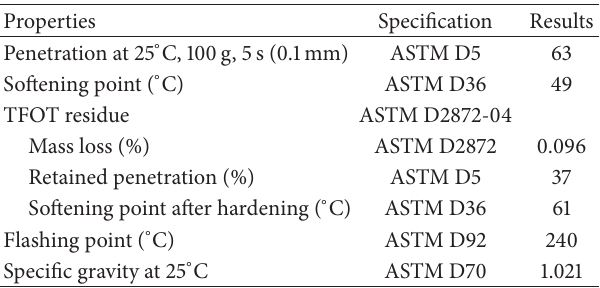
Figure 1: Aggregate gradation of porous asphalt mixture with specification limits of PEM. Table 3: Physical properties of conventional bitumen.